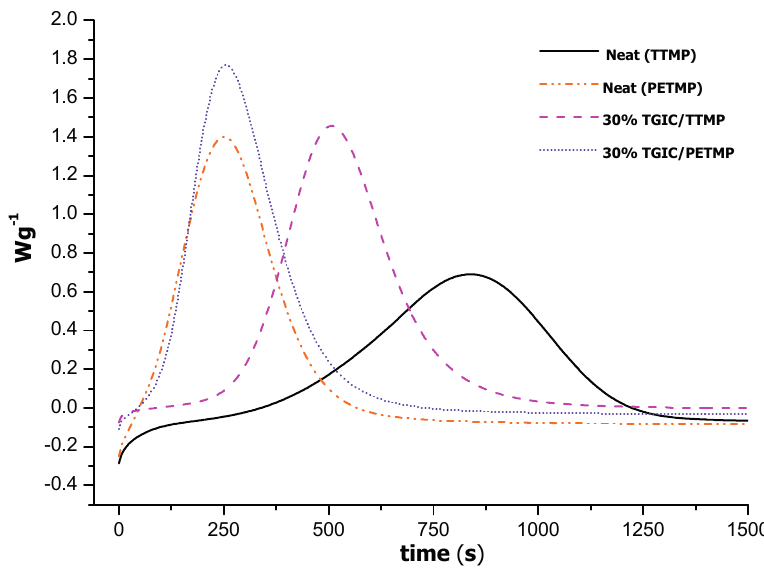
Figure 4. DSC thermograms of the isothermal curing at 100 °C of neat and TGIC mixtures with tri- and tetrathiol as curing agent.